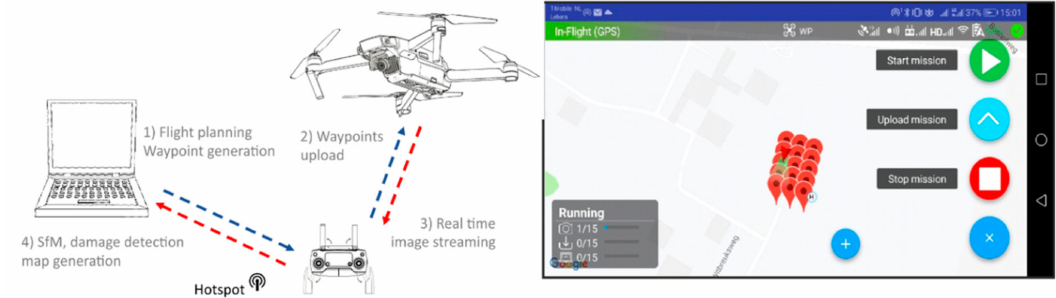
Figure 5. Workflow of the app developed for near real-time damage mapping. Images are streamed to a laptop computer and processed immediately after acquisition. A convolutional neural network (CNN)-based damage detection algorithm is applied, and a progressively built sparse 3D model is used to orthorectify them. By the time the UAV lands, an orthomosaic displaying the damage is finished (adapted from